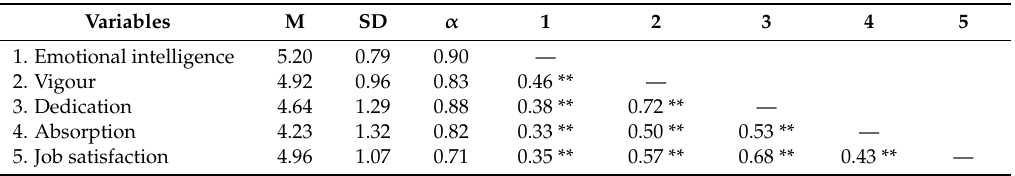
Table 2. Descriptive statistics and correlations between study